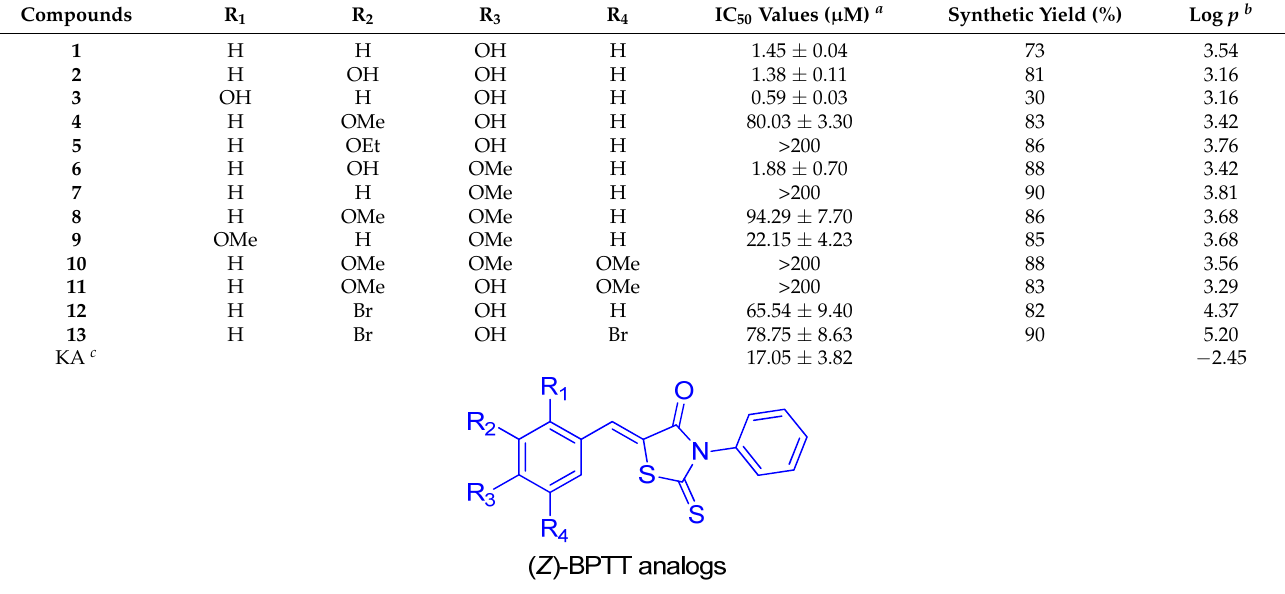
Table 2. Substitution patterns, IC 50 values, synthetic yields, and log p values of the 13 (Z)-BPTT analogs.